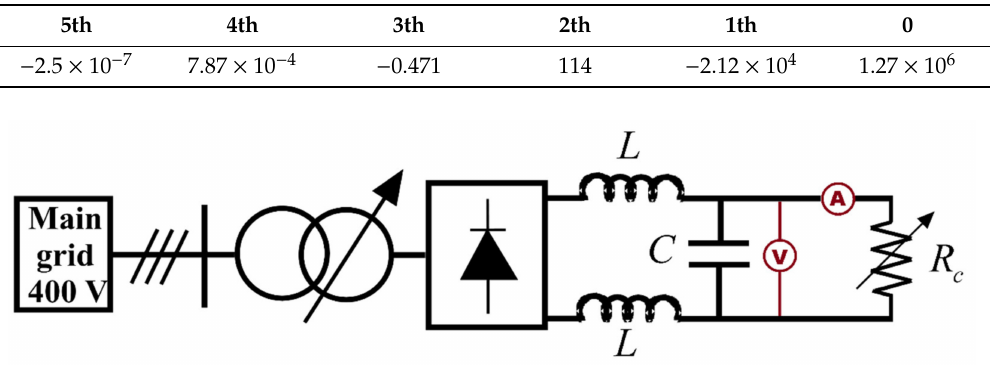
Figure A1. Characterization experiment